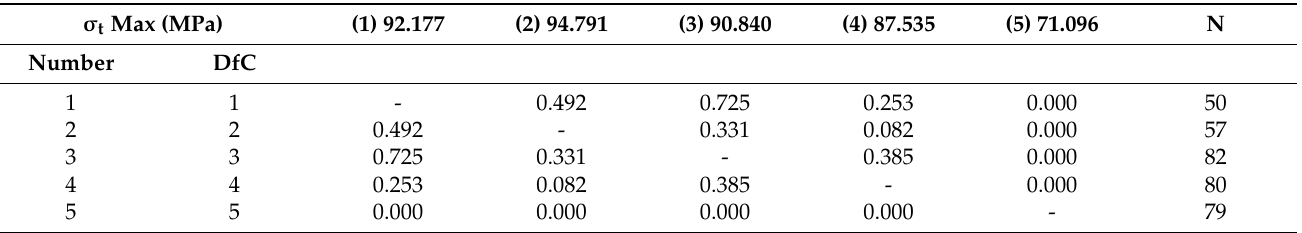
Table 4. Statistical evaluation of the effect of distance from center (DfC) on tensile strength using Duncan’s test.